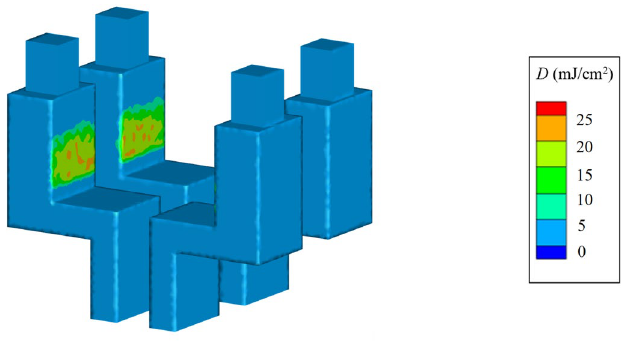
Figure 7. Far-UVC irradiation dose received by diners in the situation of “two far-UVC lamps for four diners”.